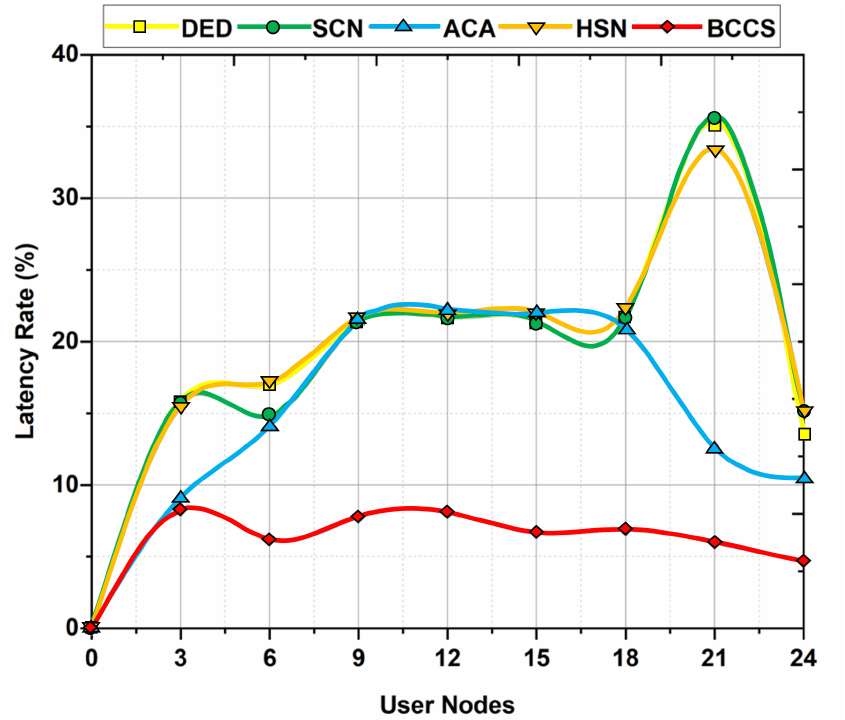
Figure 10. Latency rate (user nodes).